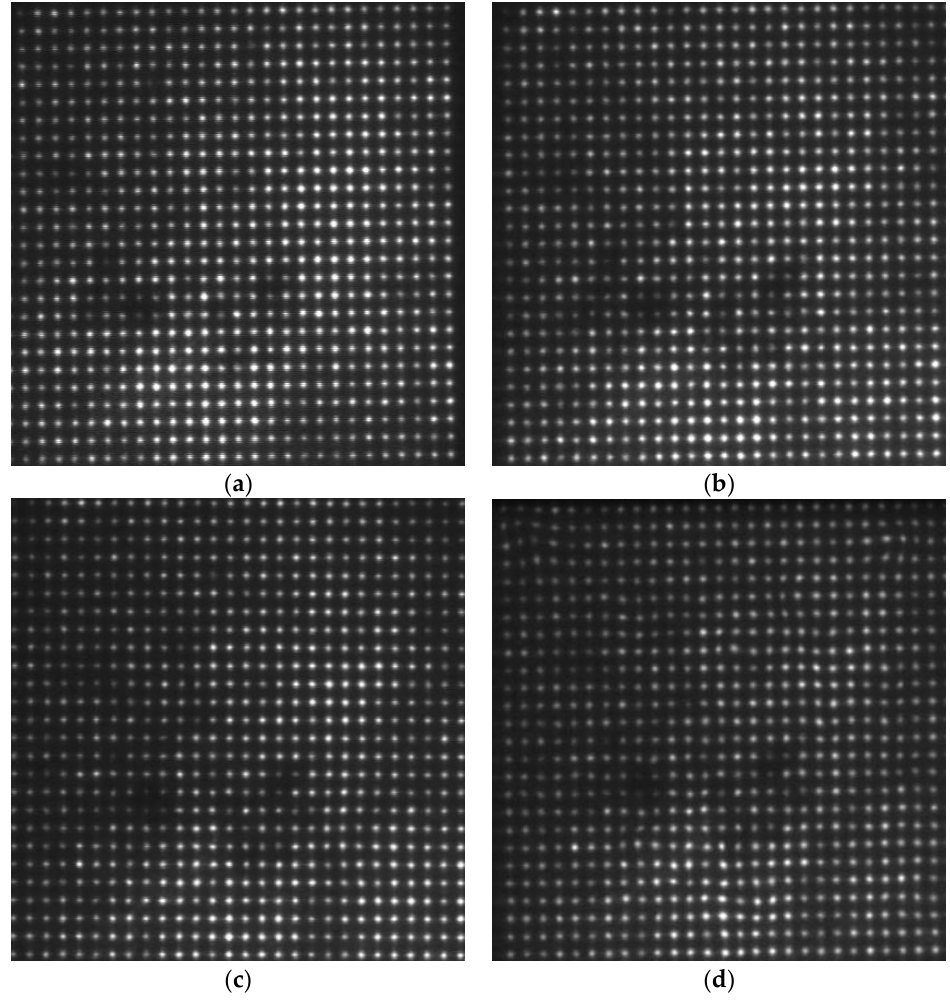
Figure 10. Focal spot images acquired from the same distance i.e., 4 m with different water flow rates: ( a ) 10 L/min; ( b ) 20 L/min; ( c ) 30 L/min; ( d ) 40 L/min.